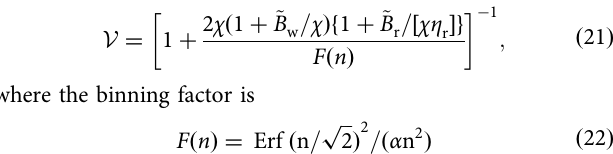
; ξ ð 2 Þ g . e – h Expected values of a measurement for subsequent combinations of w r